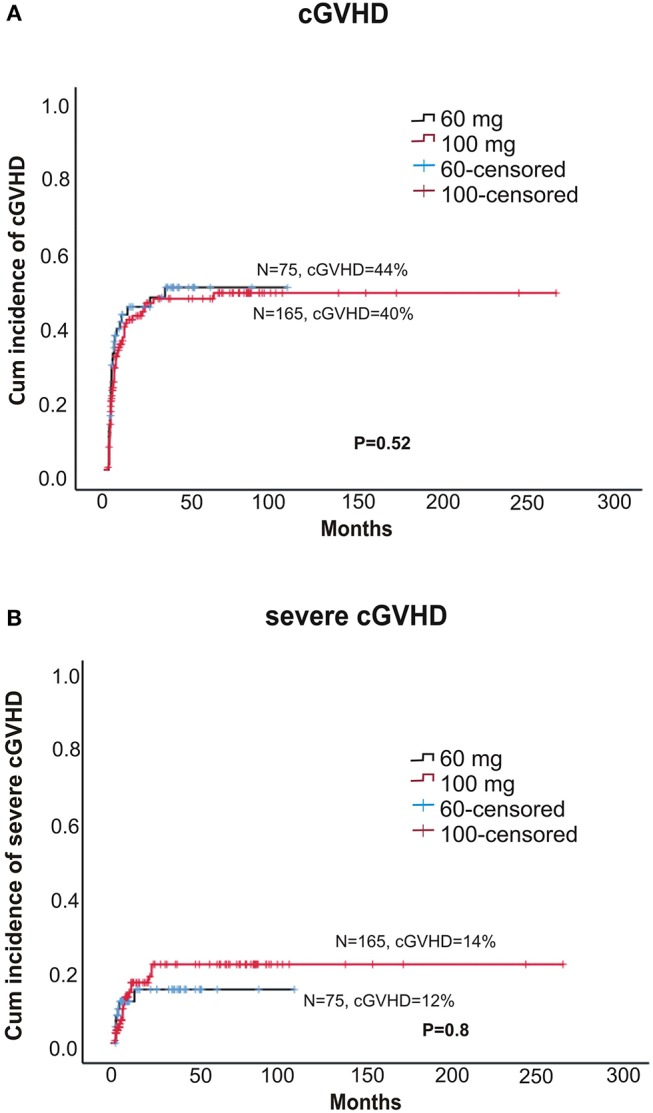
(A) Cumulative incidence of any grade chronic GVHD between two doses of alemtuzumab. (B) The cumulative incidence chronic severe GVHD between two doses of alemtuzumab.